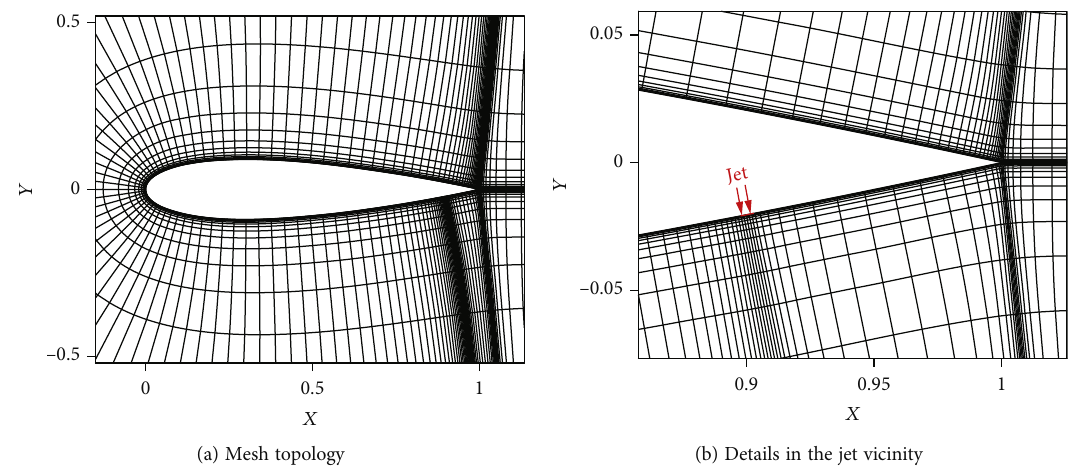
Figure 4: Computational grid around the NACA0018 airfoil with normal on the pressure surface(every 4 points).